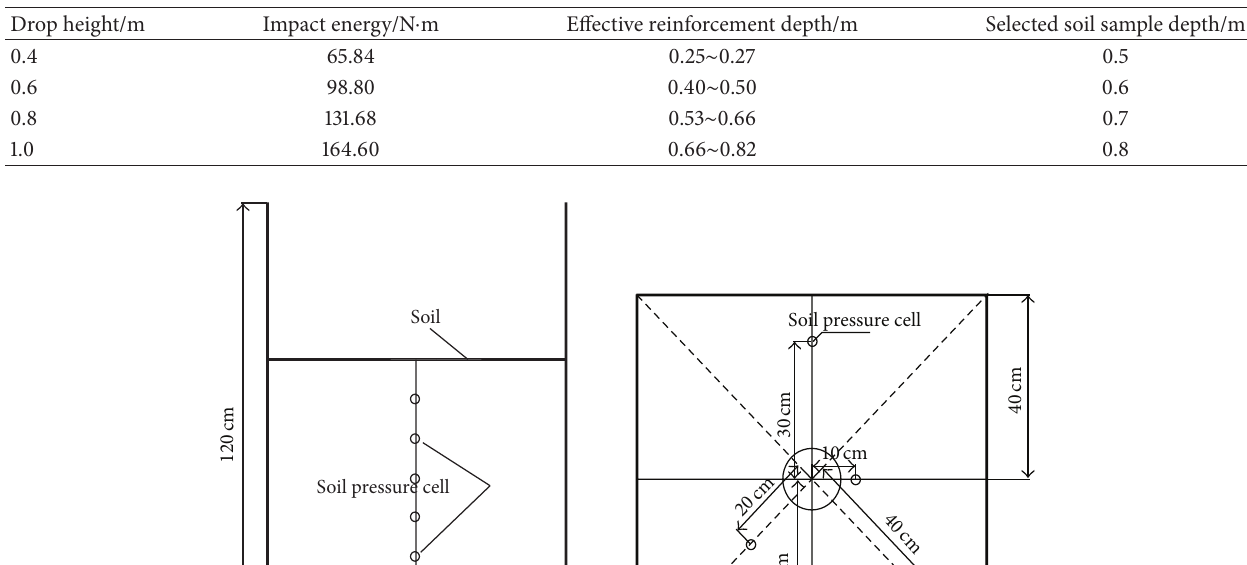
Table 2: Estimates of effective reinforcement depths under different impact energies.